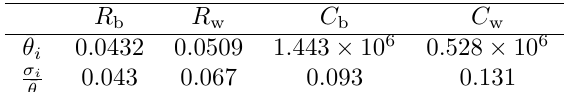
Table 5: Optimal parameters with normalised stand- ard deviations computed with the Bootstrap- ping method for the R2C2